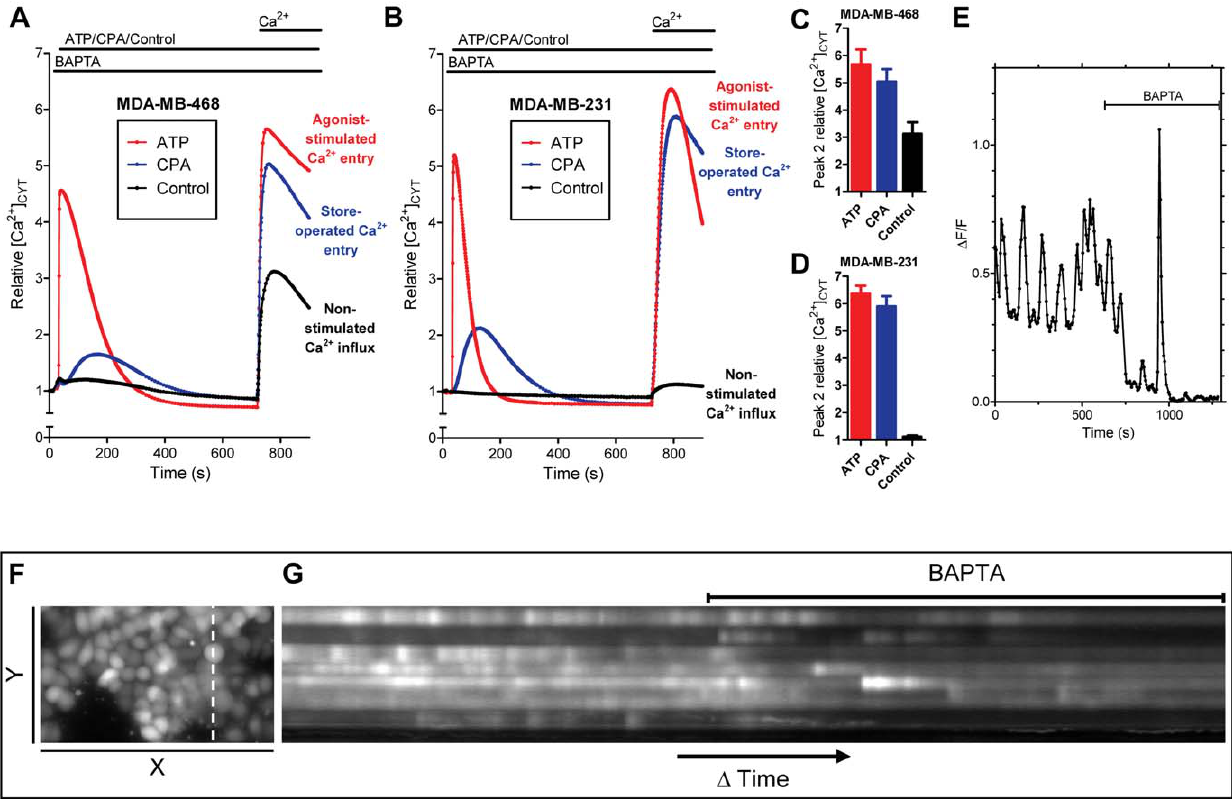
Figure 1. Assessment of cytosolic Ca 2 + signaling in MDA-MB-468 and MDA-MB-231 breast cancer cell lines. Average ATP-stimulated Ca 2 + entry response (100 m M ATP), store-operated Ca 2 + entry response (10 m M CPA) and non-stimulated Ca 2 + influx (DMSO control) were assessed in A ) MDA-MB-468 and B ) MDA-MB-231 cells. Quantitation of peak relative Ca 2 + influx (peak 2) in C ) MDA-MB-468 and D ) MDA-MD-231 cells; shown as average 6 S.D. (n=9 for MDA-MB-468 & n=4 for MDA-MB-231 cells). E ) MDA-MB-468 cells exhibit spontaneous and asynchronous Ca 2 + oscillations that are attenuated by extracellular Ca 2 + chelation (BAPTA). F ) Still image showing the Y-plane section and G ) the Y-plane projection through time. See also Movie S1. Representative of five movies from three independent